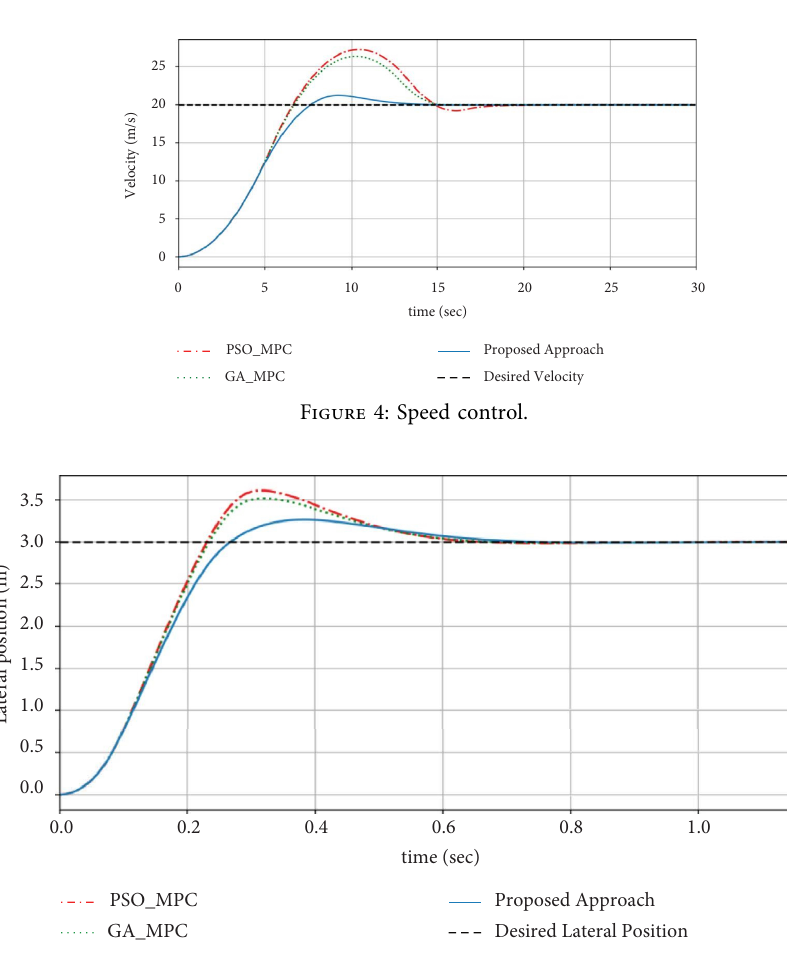
Figure 5: Lateral position control. Table 2: Te response characteristics of vehicle’s speed. Table 3: Te response characteristics of vehicle’s lateral